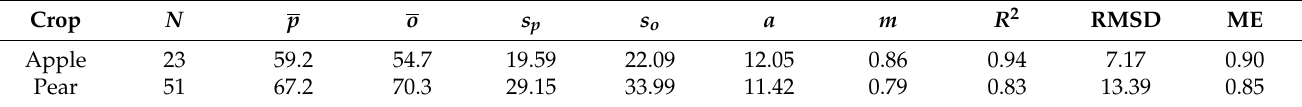
Table 6. Statistics of the predicted versus observed productivities of apple and pear crops. 1